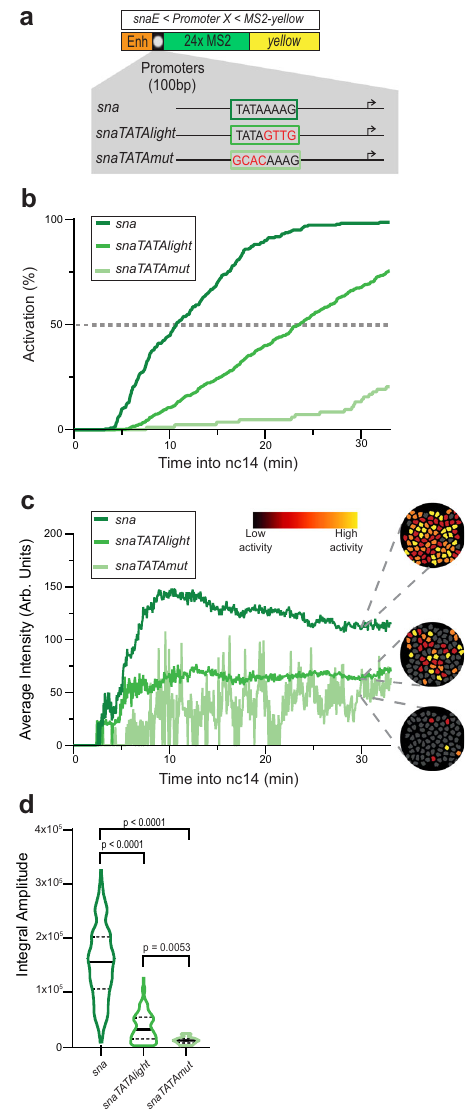
Fig. 3 Decoding the role of the TATA box on promoter dynamics. a TATA box mutations of the sna promoter. The snaTATAlight mutation corresponds to the sequence of the non-canonical TATA box from the kr promoter. b Cumulative active nuclei percentage within the mesodermal domain for sna (dark green), snaTATAlight (green), and snaTATAmut (light green). c Average instantaneous fl uorescence of transcriptional foci of active nuclei during the fi rst 30 min of nc14 for sna (dark green), snaTATAlight (green), and snaTATAmut (light green). Time zero is from anaphase during nc13- nc14 mitosis. False-colored panels on the right are colored according to instantaneous fl uorescence intensity, with inactive nuclei shown in gray and highly active nuclei in yellow. d Distribution of individual trace integral amplitudes from fi rst 30 min of nc14. The solid line represents median and dashed lines the fi rst and third quartiles, using a one-tailed Kruskal – Wallis test for signi fi cance with multiple comparison adjustments. Statistics: snaE < sna , 216 nuclei, 3 movies; snaE < snaTATAlight , 353 nuclei, 6 movies; snaE < snaTATAmut , 21 nuclei, 3 movies. See Supplementary Movies 1 –